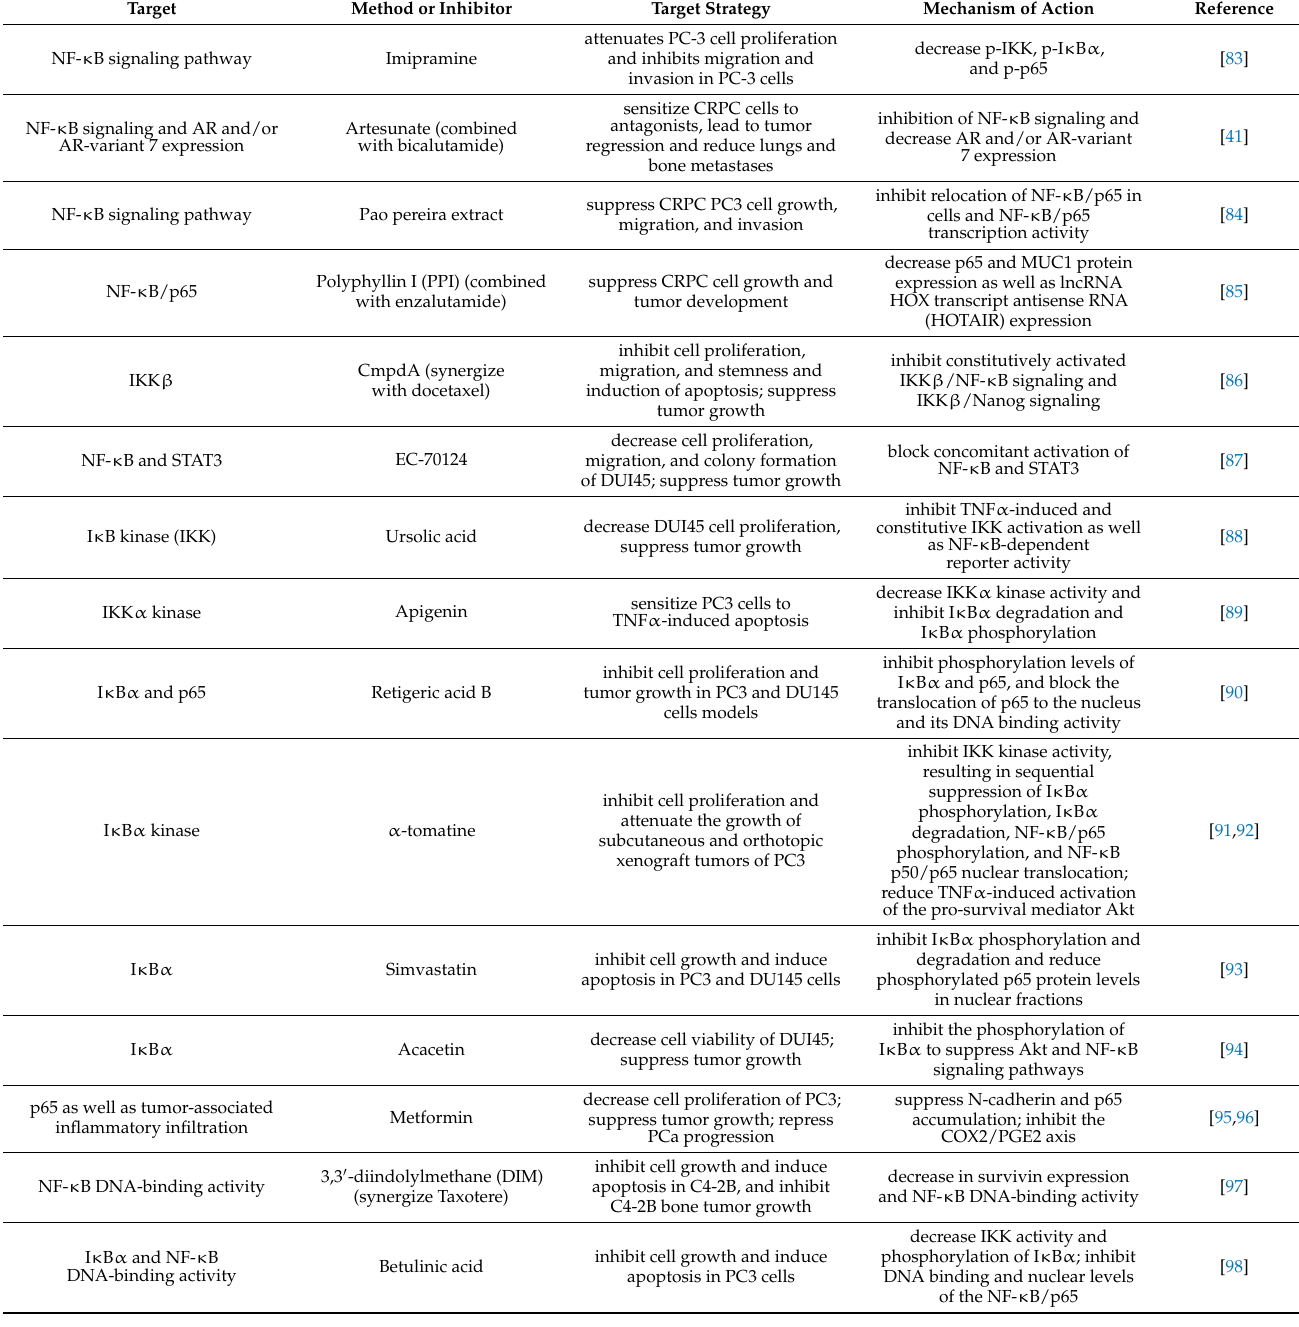
Table 1. NF- κ B pathway-related inhibitors that target inflammatory signaling in